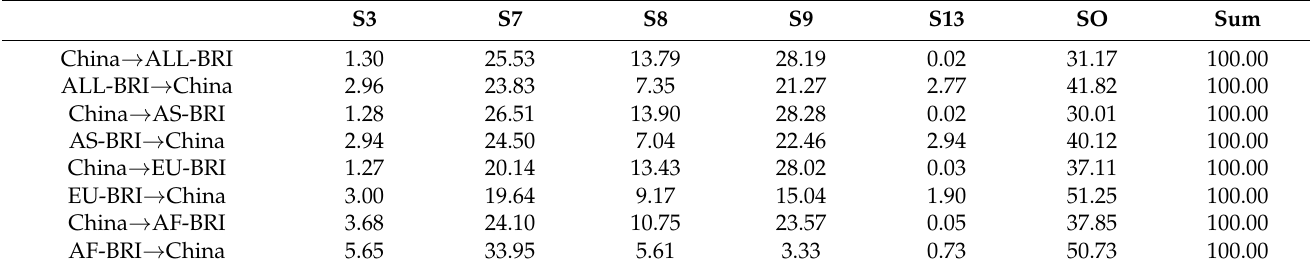
Table 2. Sectoral share of intermediate product trade between China and BRI countries (%).